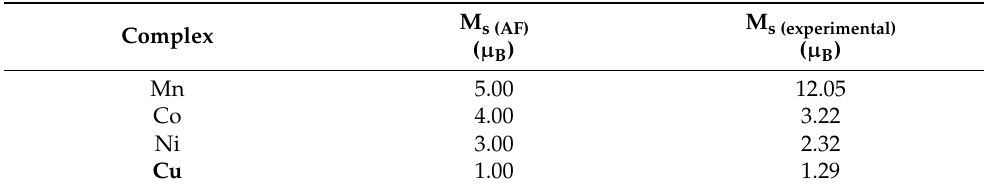
Figure 5. Magnetization (M) vs. magnetic field (H) plots at 2 K for [M 3 ( µ -L) 6 (H 2 O) 6 ] − 6 complexes and their corresponding fit curves (red line) obtained with the MAGPACK package, with the resulting parameters of XT vs. T best-fitting. Table 2. Comparison of experimental and theoretical saturation magnetization for the antiferromag- netically (AF) coupled ground state with g = 2 for all the